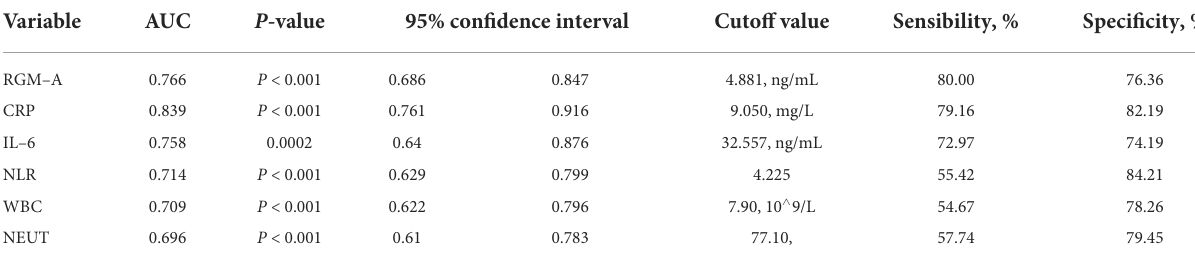
TABLE 4 Comparison of predictive power of RGM–A vs. conventional inflammatory indicators in the prediction of SAP.